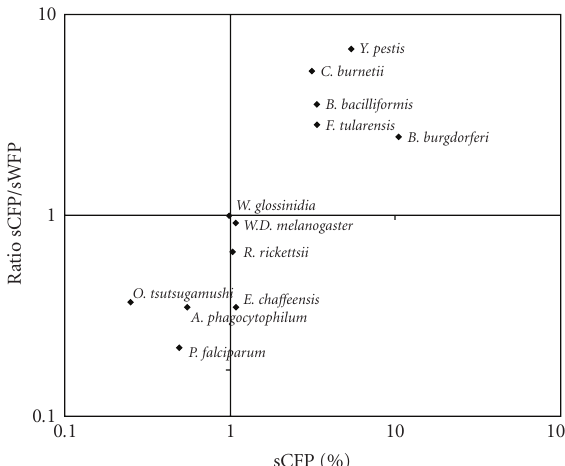
Figure 2: Frequency of sCFPs (percentage) plotted against a ratio of sCFP/sWFP in 12 arthropod-borne microorganisms. A logarithmic scale of the x and y axes was used to improve visual separation of microorganisms with low sCFP/sWFP ratios.